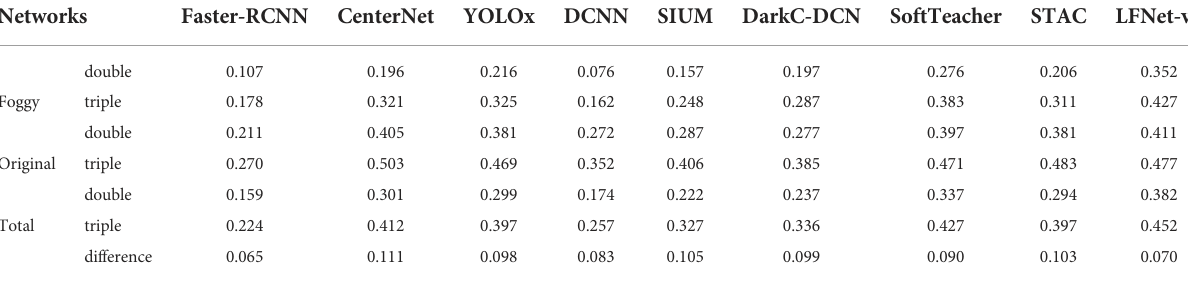
TABLE 6 Ablation study for triple classi fi cation assistance on eight state-of-the-art object detection networks. Networks